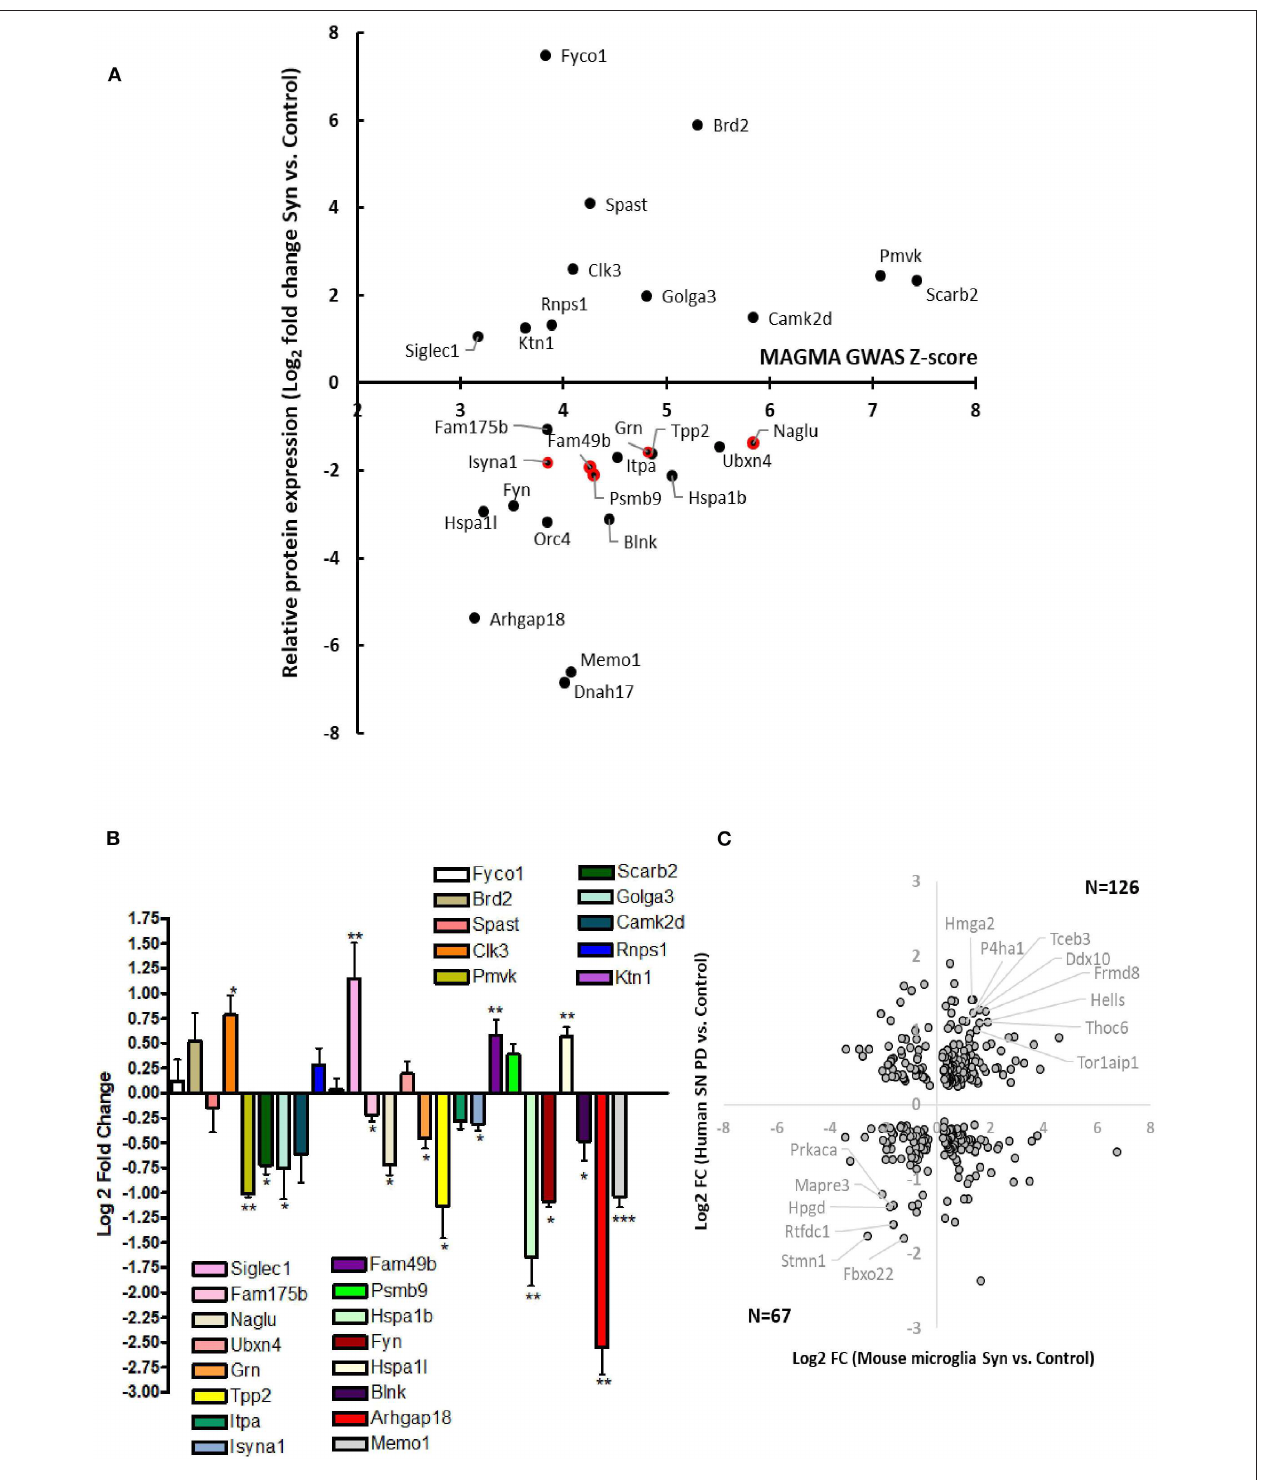
FIGURE 4 | Identification of Syn-induced microglial proteomic changes that are relevant to human PD pathogenesis . (A) MAGMA analysis of PD GWAS risk genes that are also differentially expressed in response to Syn. The 5 gene symbols highlighted in red represent proteins that are also most highly expressed in microglia as determined by CNS cell-type-specific proteomics. (B) qRT-PCR validation studies of human PD GWAS and Syn-regulated proteins in primary mouse microglia. (C) Comparison of results from MMC Syn vs. control proteomics dataset and PD vs. control substantia nigra microarray study. 39 gene symbols showed differential expression at the unadjusted p < 0.05 level. Of these 193 (57%) showed concordant changes in both datasets. Gene symbols meeting at 2-fold change in both datasets are highlighted (8 concordantly upregulated and 6 concordantly downregulated).